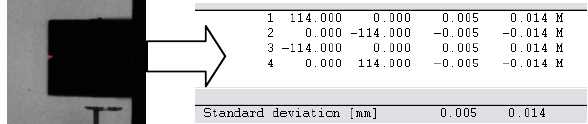
Figure 4. Remaining errors after the adjustment (north facade)